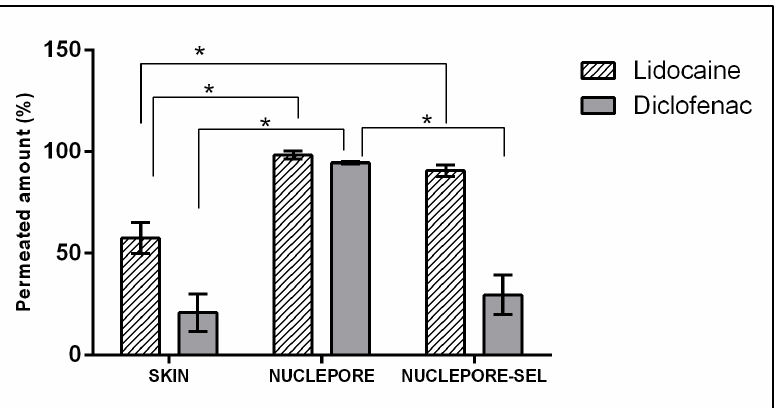
Figure 1. Normalized permeated amounts (%) in the skin, Nuclepore ® , Nuclepore ® -SEL for lido- caine, and diclofenac sodium. (*) denotes a p - value ≤ 0.05 from the test of Kruskal